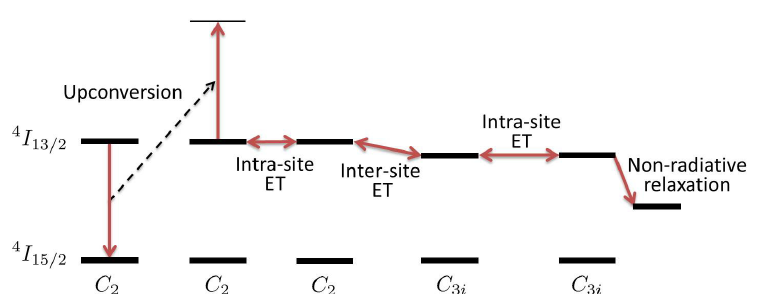
Figure 1. Various energy transfers that are observed in the transition between the Stark levels of 4 I 15/2 and 4 I 13/2 in the (Er x Sc 1 − x ) 2 O 3 crystal. ET: energy transfer.